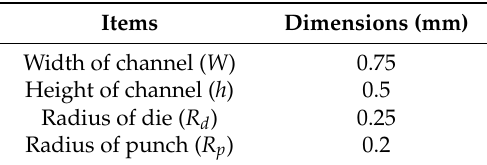
Table 2. Mechanical properties of stainless steel SUS304.